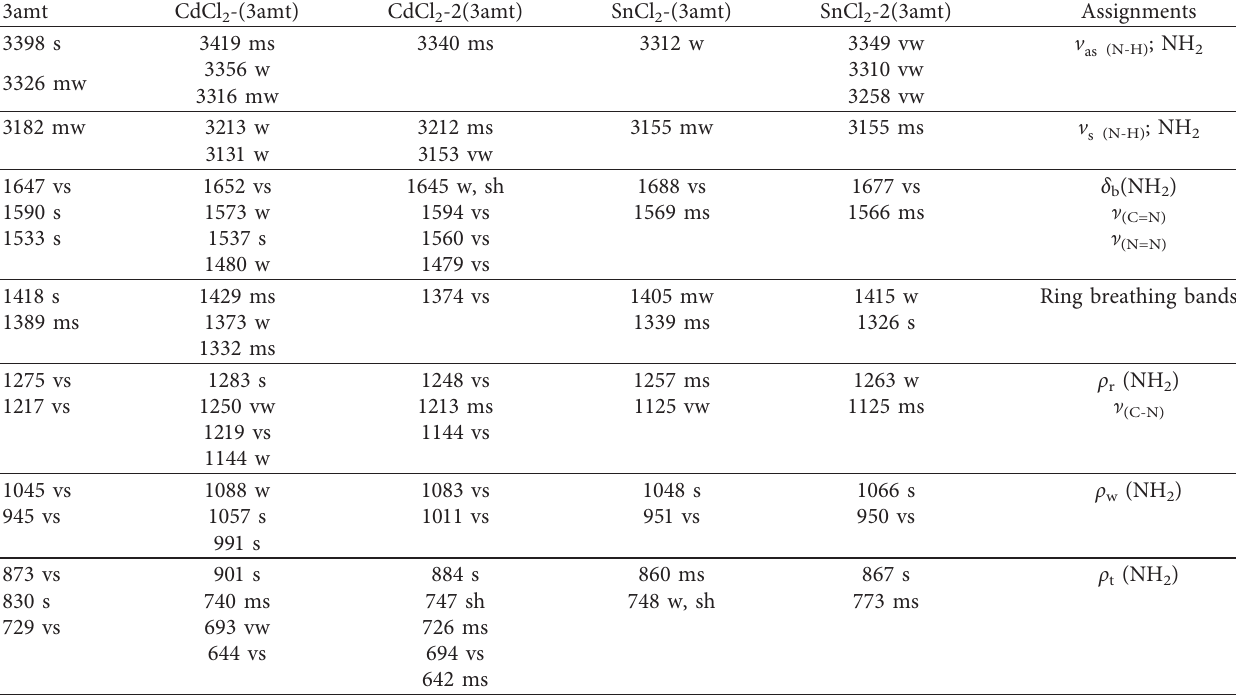
Table 2: Major infrared bands (cm − 1 ) for 3amt and its Cd(II) and Sn(II) adducts.